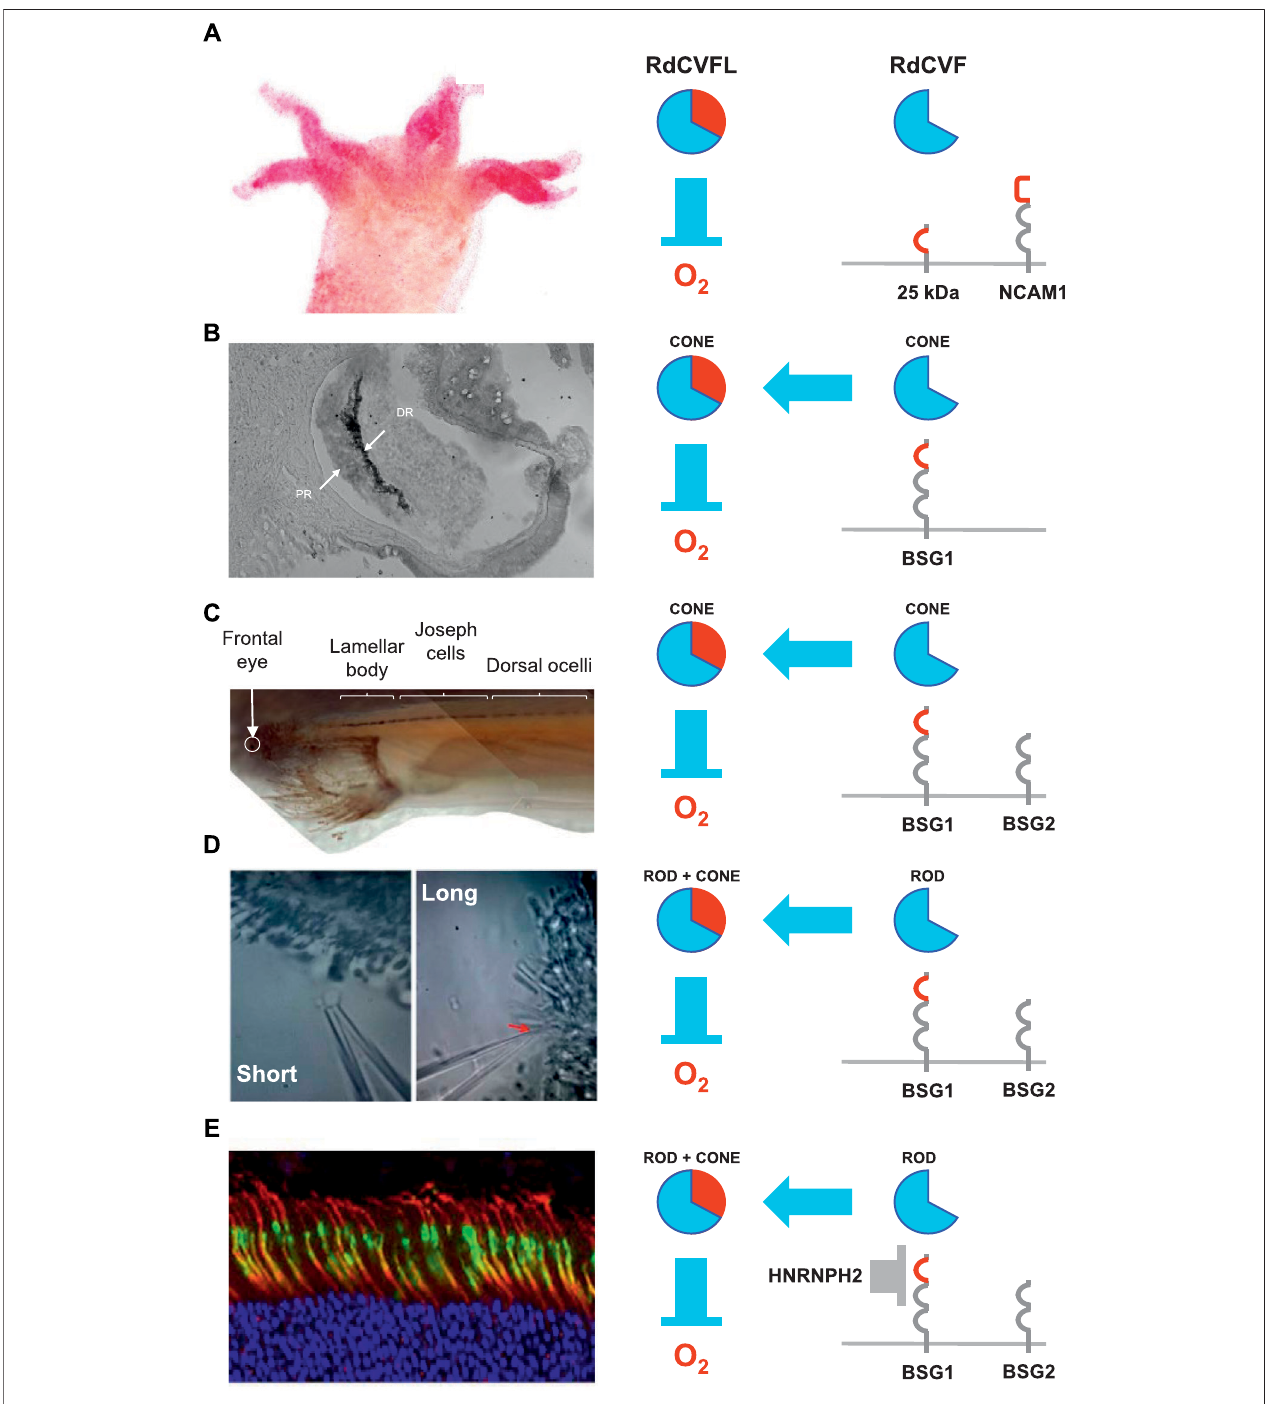
FIGURE 2 | Evolution of the of the nucleoredoxin-like 1 gene. (A) Hydra vulgaris . (B) Patinopecten yessoensis (scallop). DR: distal retina. PR. (C) Branchiostoma lanceolatum (amphioxus). (D) Petromyzon marinus (lamprey). (E) Mus musculus (mouse). HNRNPH2: heterogeneous nuclear ribonucleoprotein H2.